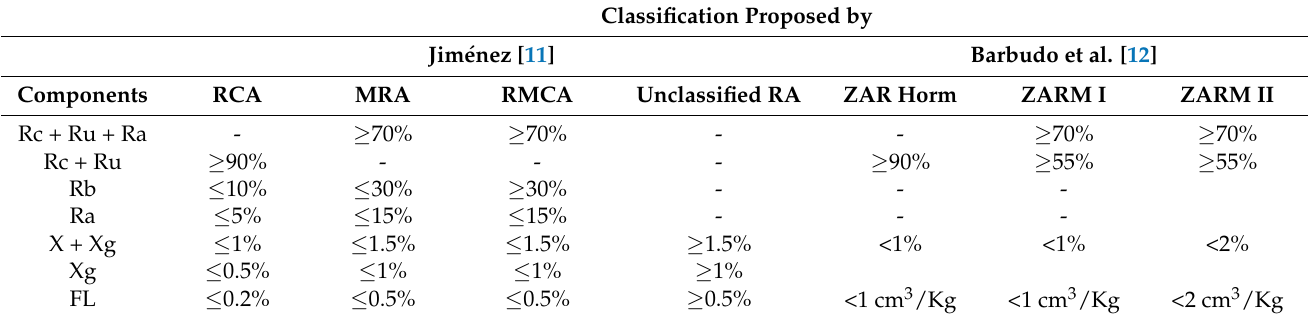
Table 1. Classification of RA according to composition test EN 933-11:2009 proposed by Jim é nez [11] and Barbudo et al. [12]. Classification Proposed